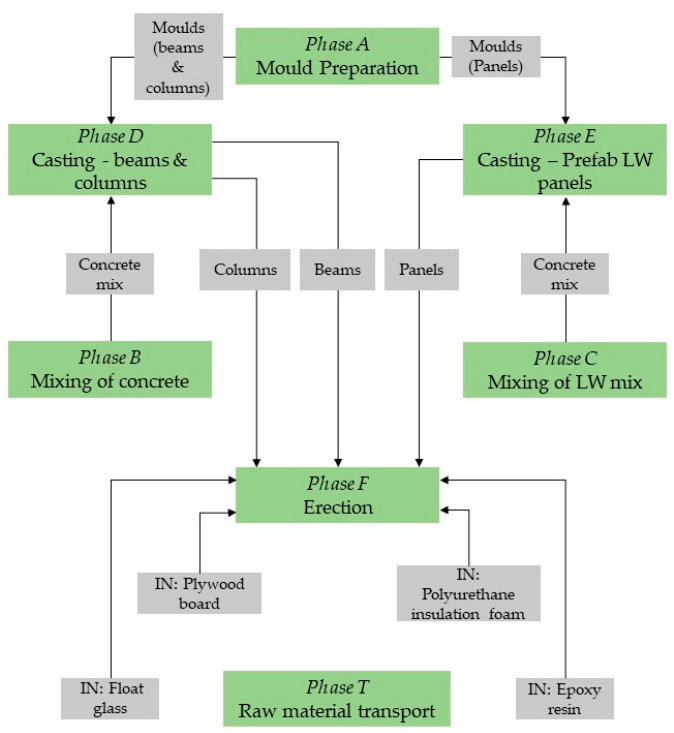
Figure 6. System boundaries and fl owchart.